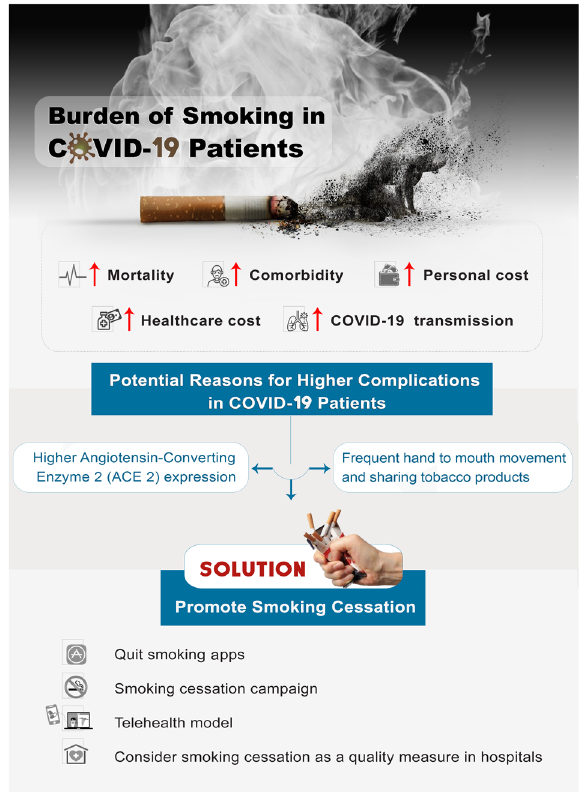
Fig. 1 Burden of smoking in COVID-19 patients and role of smoking cessation. Smoking is associated with increased risk of severe COVID-19 and mortality that are linked with ACE 2 overexpression and frequent hand to mouth movement. The health cost of COVD-19-associated morbidity can be reduced via the promotion of smoking cessation through apps, public health campaigns, telehealth models and the hospital quality